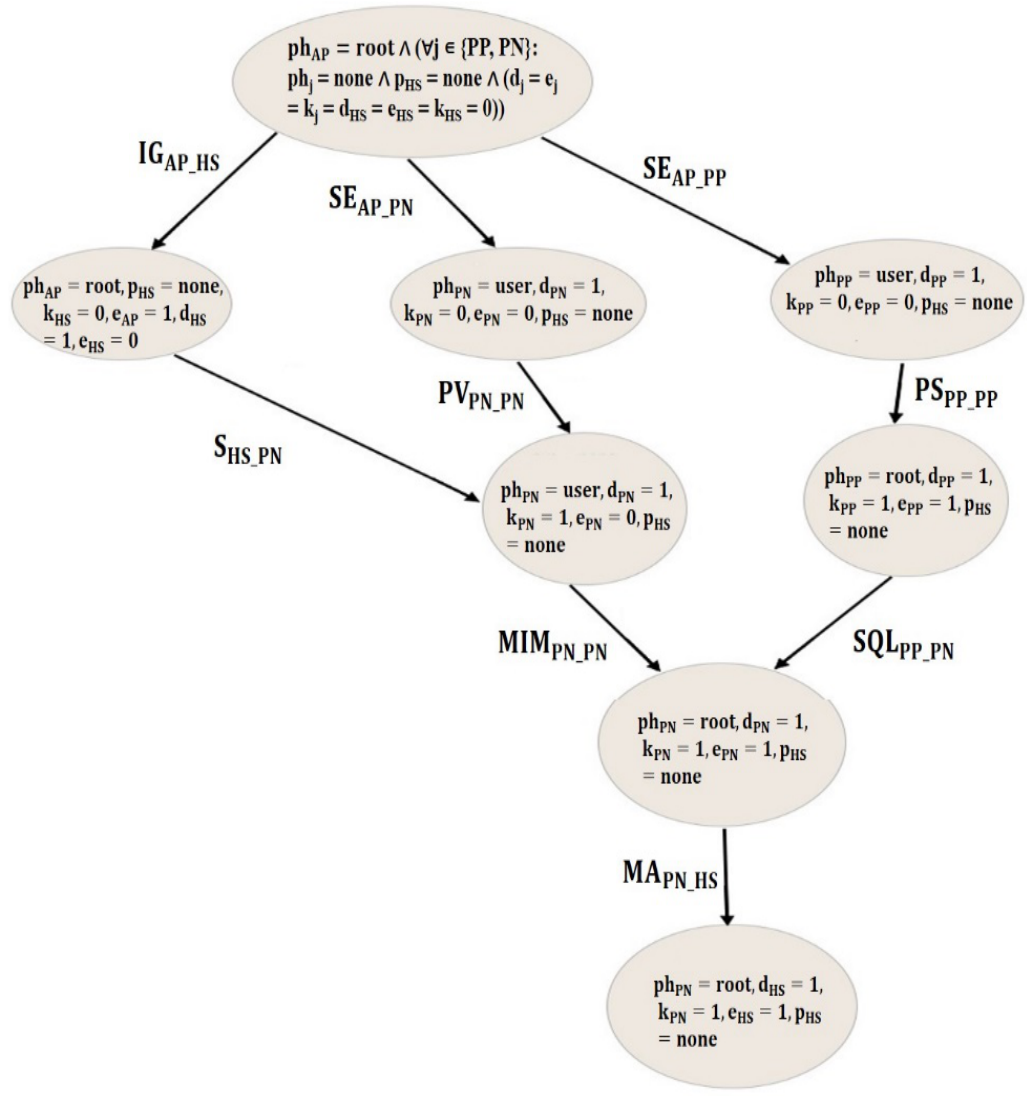
Figure 4. PARMS generated attack graph. MA: Malware Injection, SE: Social Engineering, IG: